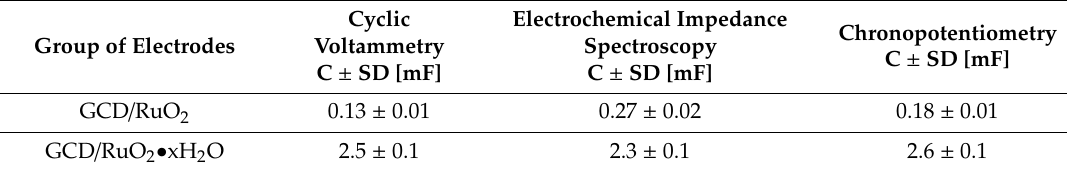
Figure 5. Comparison of electrochemical properties of anhydrous (violet curve) and hydrous (blue curve) RuO 2 tested with the use of cyclic voltammetry in the potential range from 0 to 0.3 V, inset: voltammogram of hydrous RuO 2 registered in a broader potential window from − 1.0 to 1.0 V. Remaining cyclic voltammetry (CV) parameters: scan rate: 0.1 V/s, electrolyte: 0.01 M KCl. Table 1. Electrical capacitance of layers (n = 3).